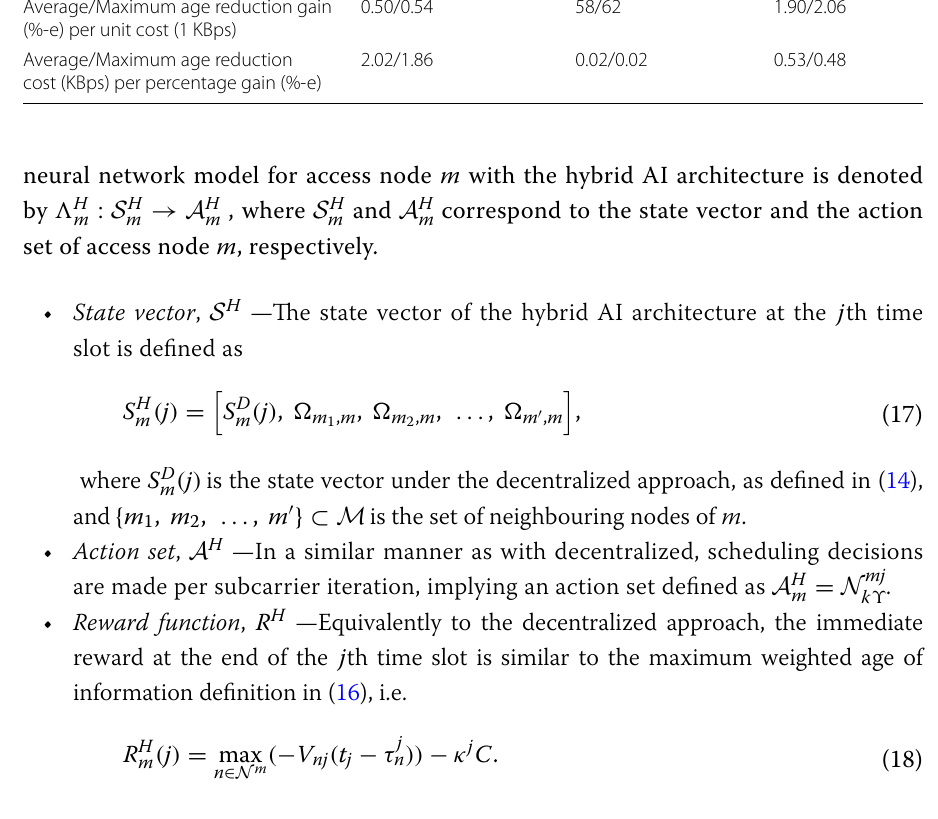
Table 7 Performance comparison for the three learning systems Learning system Centralized